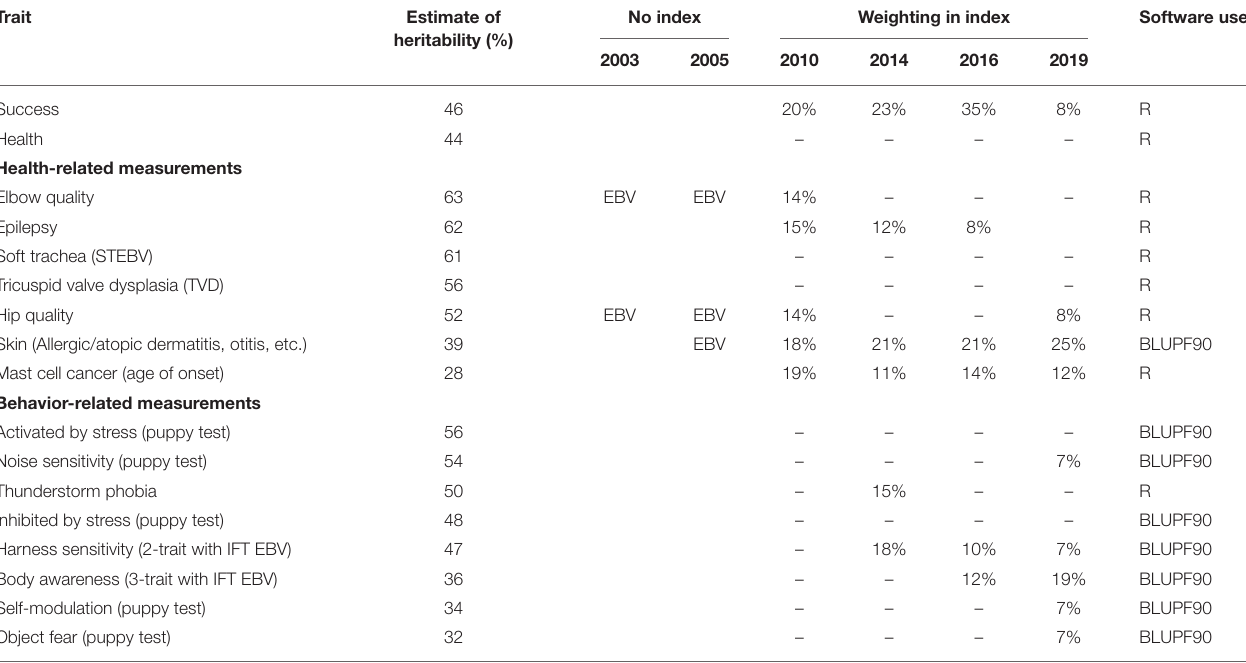
TABLE 1 | Heritability and genetic selection at Guiding Eyes. Trait Estimate of